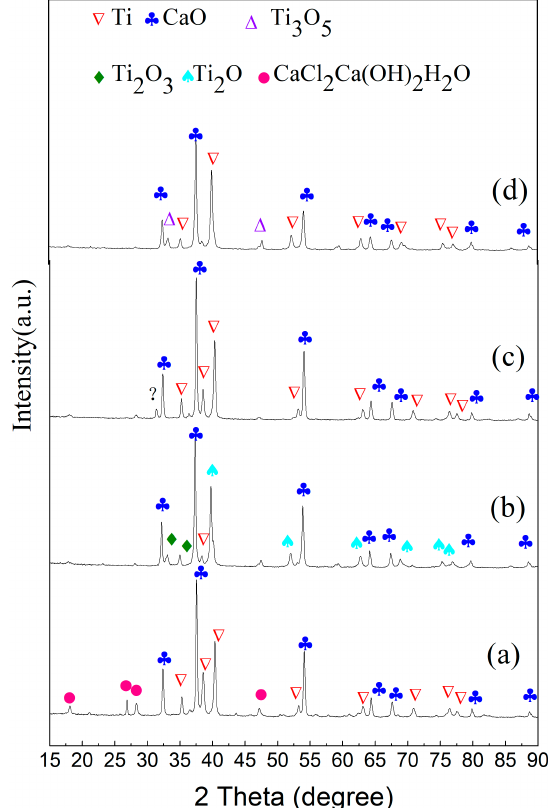
Figure 6. XRD analysis of reduction products with different time and regions at 1273 K: ( a ) surface of reduction product for 30 min; ( b ) interior of reduction product for 30 min; ( c ) surface of reduction product for 1 h; ( d ) interior of reduction products for 1 h.